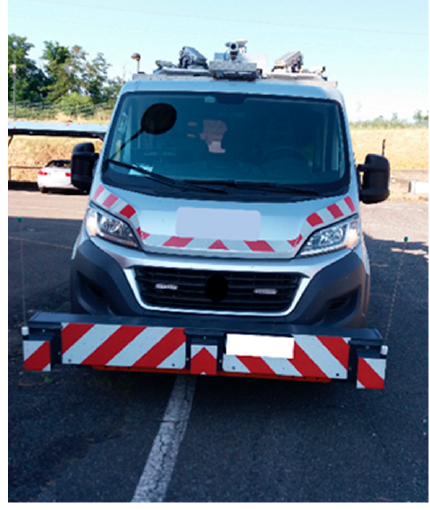
Figure 1. A modern data collection vehicle.